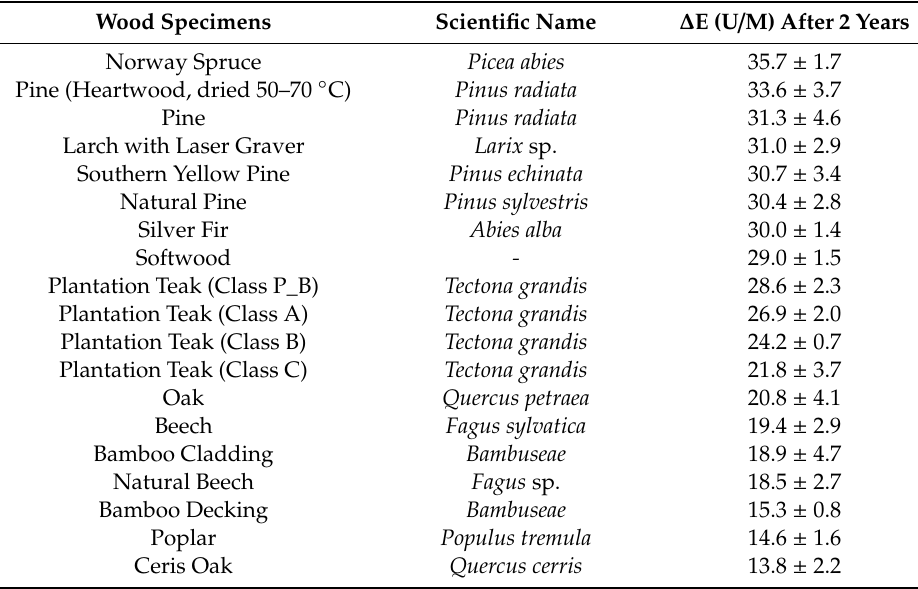
Table 1. Colour changes of natural specimens.